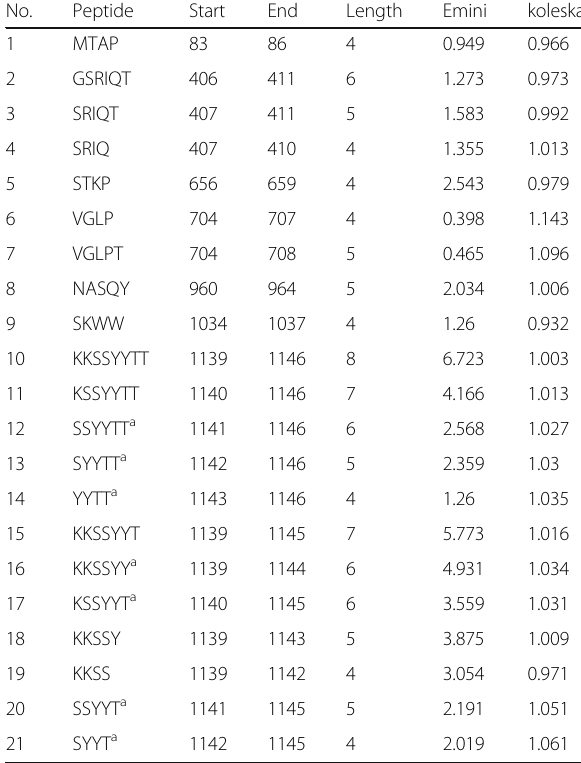
Table 4 List of shortened B cell epitopes predicted by